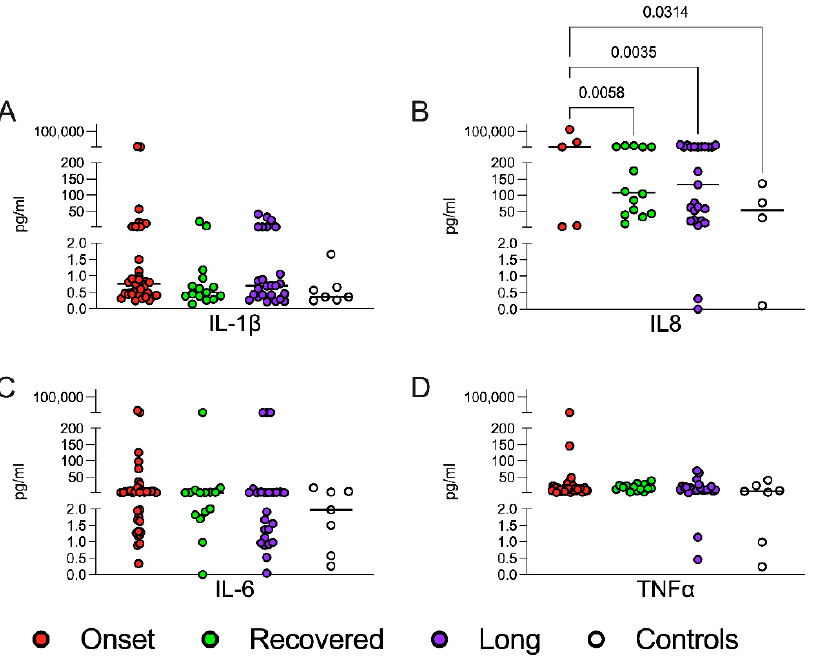
Figure 2. Cytokine levels in the sera. Cytokine expression was measured in sera samples of patients and healthy subjects at data entry (ELLA Assay, ProteinSimple, San Jose, CA, USA). Each circle represents the concentration (expressed as picograms/milliliter, pg/mL) of the cytokines for each patient/healthy subject, and the 4 plots compare the four groups. Statistical analyses were performed with a two-way ANOVA corrected with Tukey. ( A ) IL1 β : interleukin 1 β ; ( B ) IL8: interleukin 8; ( C ) IL6: Interleukin 6; ( D ) TNF α : tumor necrosis factor α . IL8 plot (Figure 2B) displays a limited number of patients/healthy subjects. The missing ones are not shown because they were